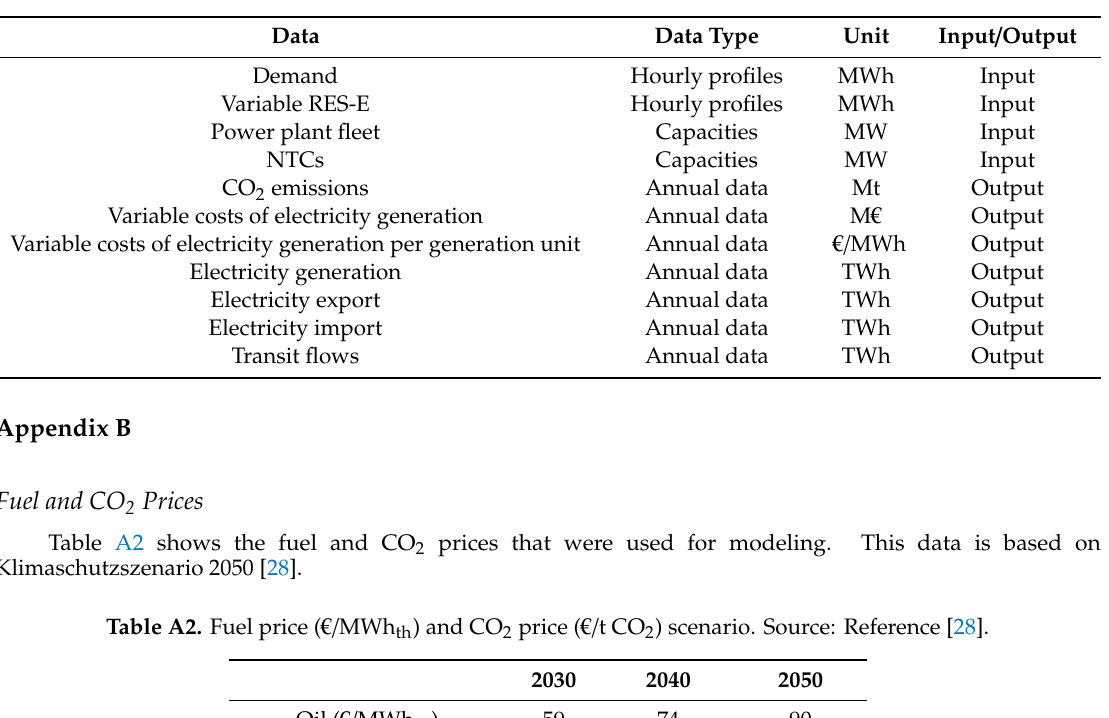
Table A1. Fuel price ( € / MWh th ) and CO 2 price ( € / t CO 2 ) scenario.